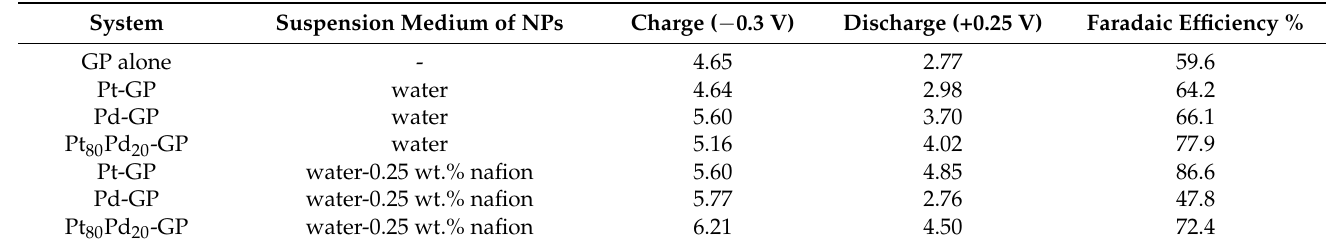
Table 3. Charge—discharge specific capacity (Ahg − 1 ) and Faradaic efficiency of the NPs-GP systems. Conditions: KOH 1 M; current ± 100 µ